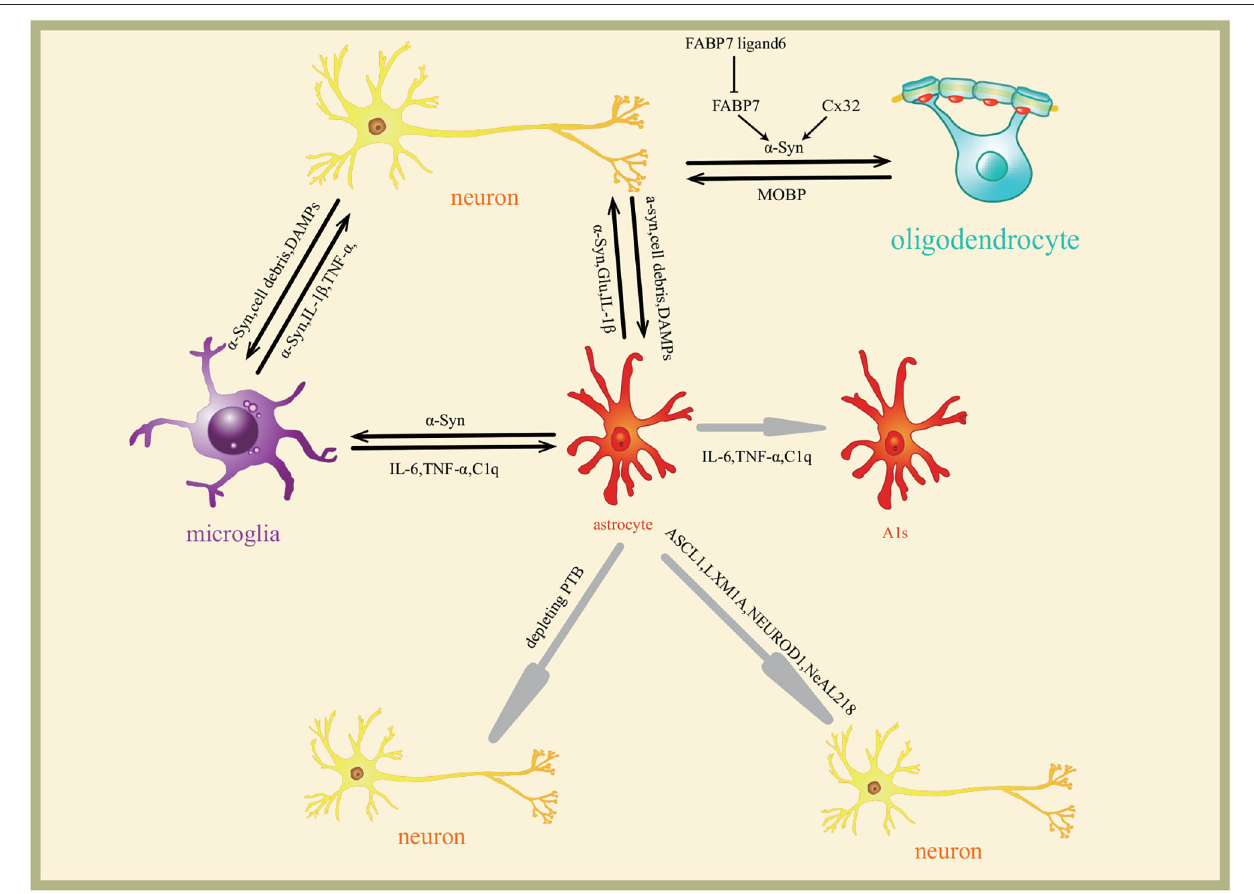
FIGURE 3 | Interaction of glia and neurons in Parkinson’s disease. Neurons secrete α -syn to extracellular matrix which induces glia reaction differently. The molecules are transmitted among neurons and glia to form a complex regulating network. Astrocytes are induced to A1s by microglia through inflammatory factors IL-6, TNF- α , and C1q. Astrocytes are converted into functional neurons by ASCL1, LMX1A, NEUROD1, and NeAL218 transcription programs. Cx32 and FABP7 regulate the oligodendrocytes